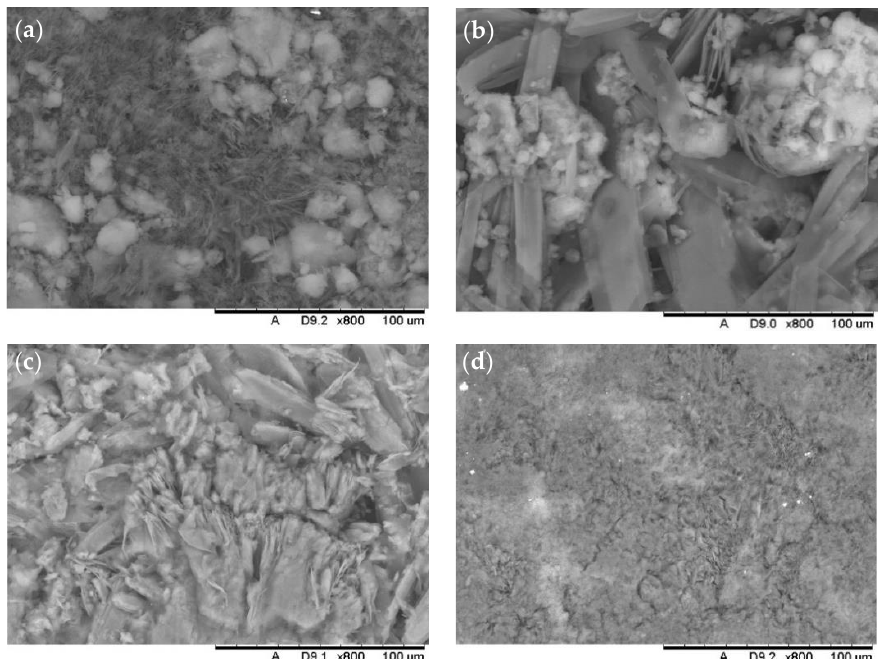
Figure 5. SEM images of fabricated coatings after immersion in ( a ) formulation 6 (IPA, 2% wt. 1 M NaOH (aq), 0.05 M stearic acid and micro-SiO 2 ), ( b ) formulation 7 (IPA, 2% wt. 1 M NaOH (aq), 0.1 M stearic acid and micro-SiO 2 ), ( c ) formulation 8 (IPA, 2% wt. 1 M NaOH (aq), 0.2 M stearic acid and micro-SiO 2 ) all for 360 min and ( d ) formulation 8 (IPA, 2% wt. 1 M NaOH (aq), 0.2 M stearic acid and micro-SiO 2 ) for 120 min.